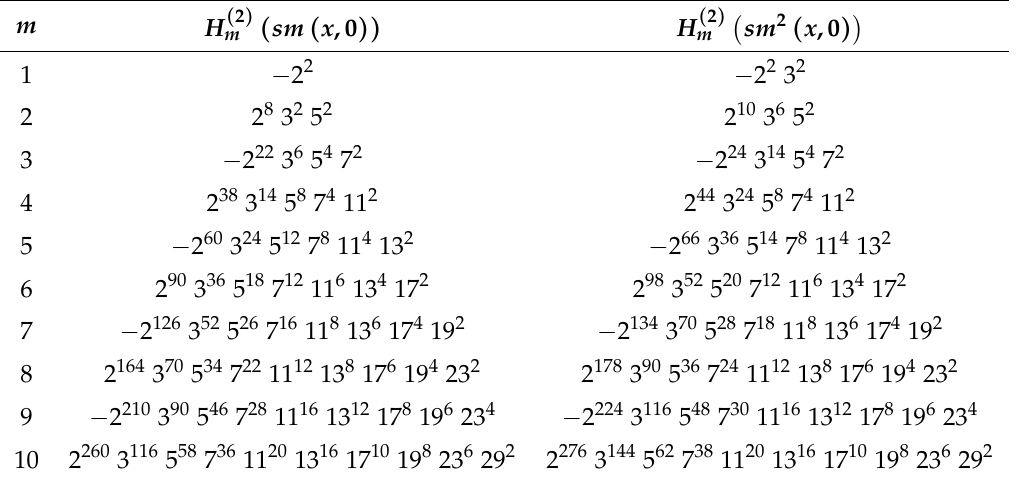
( 2 ) ( . ) of the Dixon elliptic functions sm ( x ,0 ) and sm 2 ( x ,0 ) for m from 1–10. m